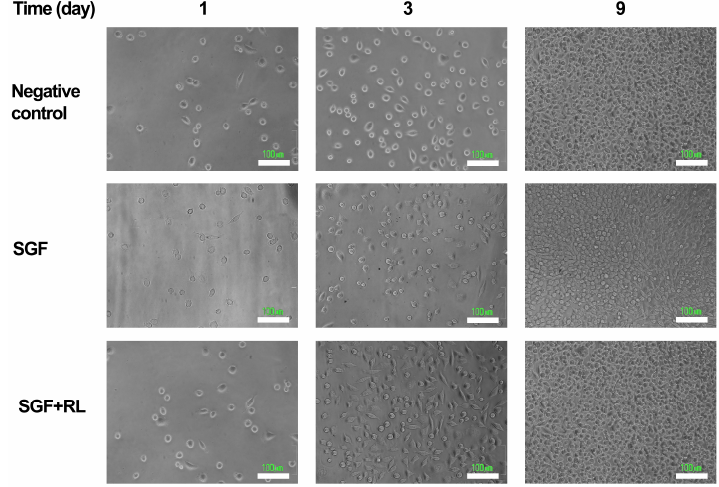
Figure 6. Photomicrographs showing L929 mouse fibroblast cultures seeded in different chambers: 1, 3, and 9 days after seeding. “Negative control” means standard cell culture chamber without any modification, “SGF” refers to chambers containing SGFs but without irradiation stimulus, and “SGF + RL” means chambers containing SGFs that received irradiation of RL light ( λ = 650 nm). (Scale bar is 100 µm).